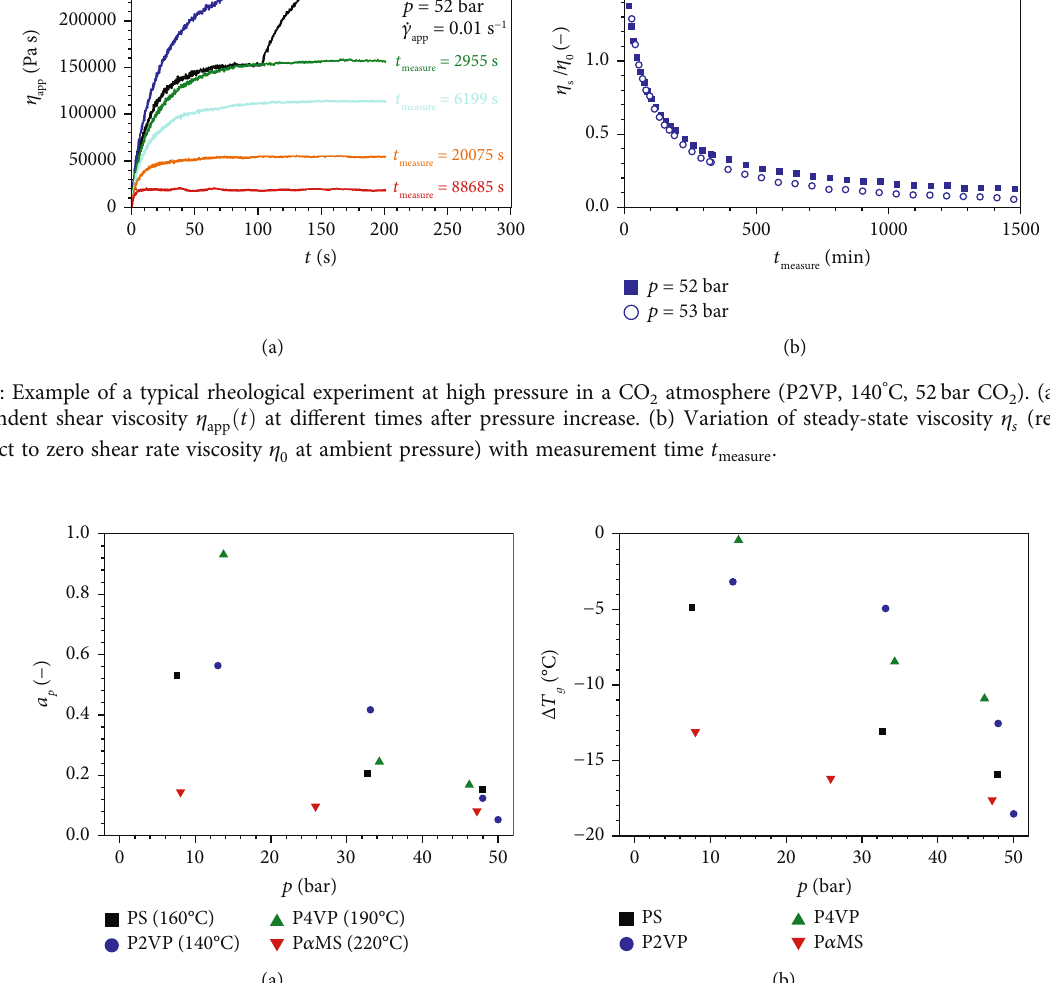
Figure 15: In fl uence of carbon dioxide loading on (a) relative reduction η the glass transition temperature T